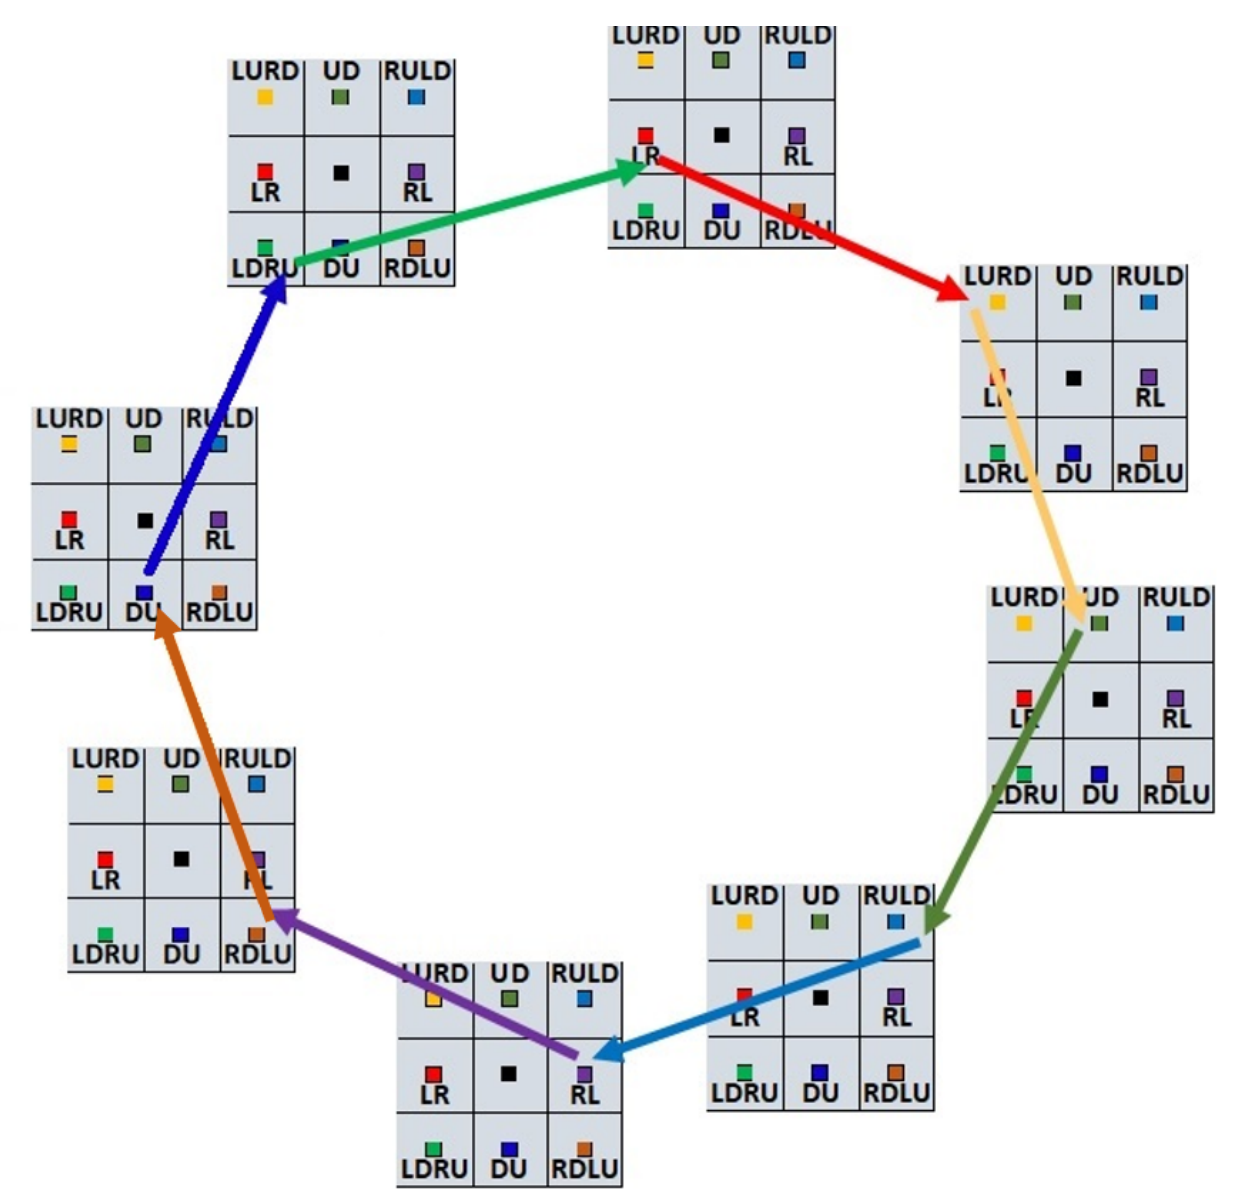
Figure 11. Eight sequential clockwise turns for eight cells. Each node within a cell has its own cycle of clockwise turns which are not shown here to make the figure simpler. The arrows are in the same color as their starting